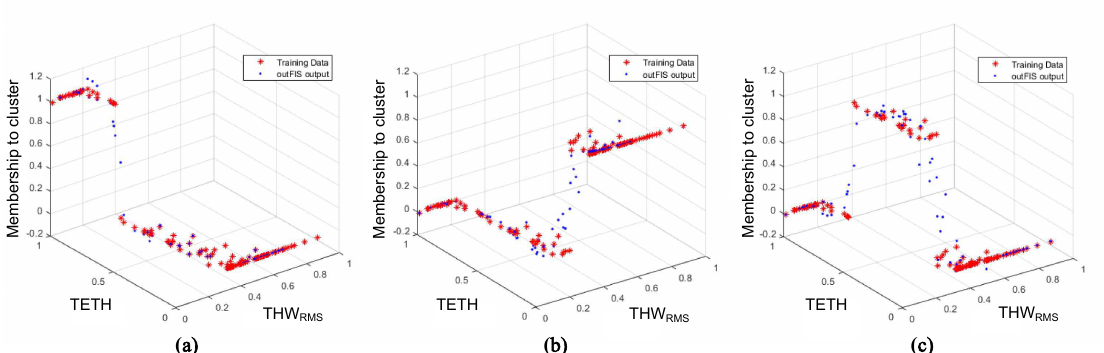
Figure 7. ( a ) Adaptive neuro-fuzzy inference system (ANFIS) 1 (Cluster 1), ( b ) ANFIS 2 (Cluster 2), and ( c ) ANFIS 3 (Cluster 3). Training data shown in red; response of corresponding trained ANFIS shown in blue.